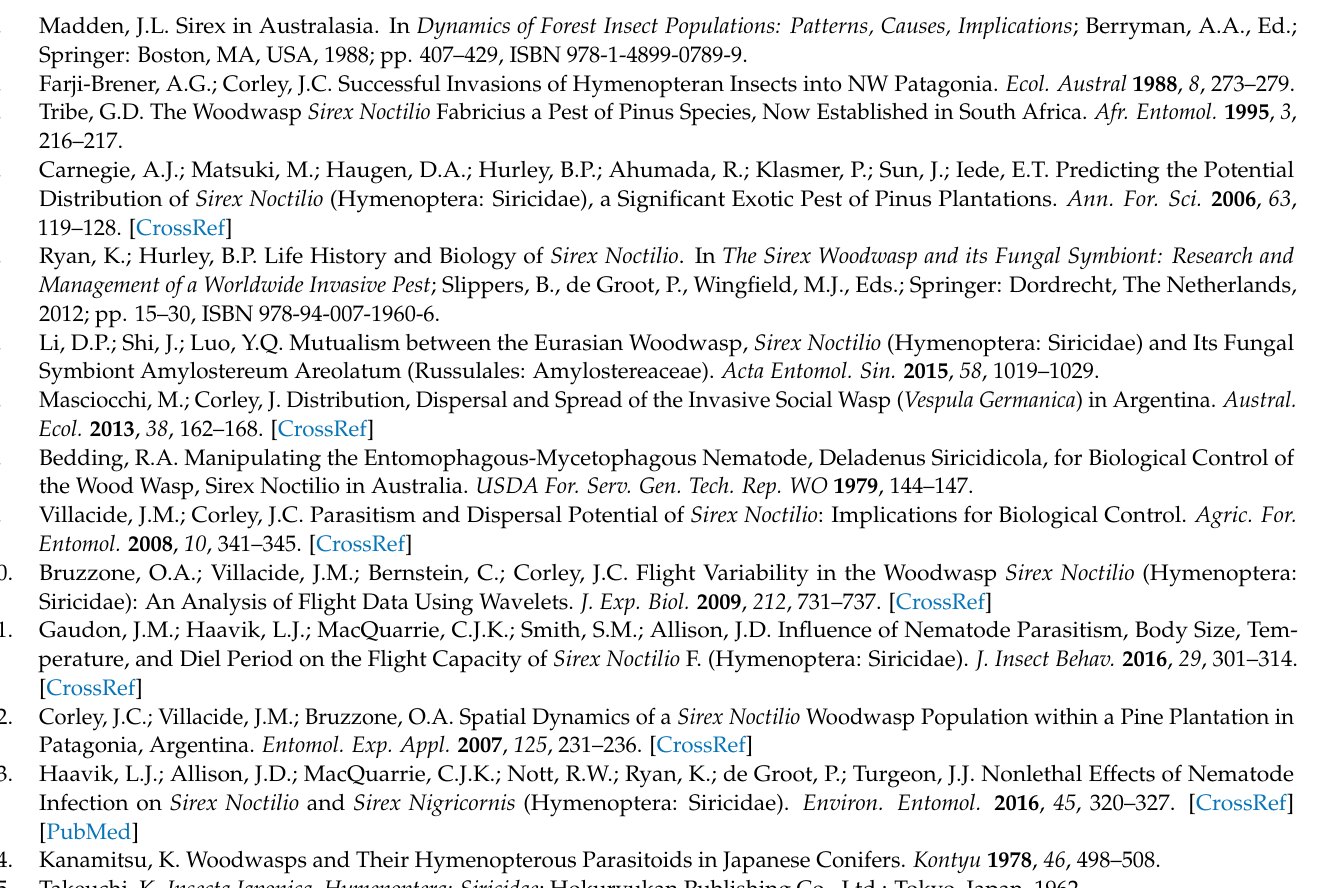
Data are presented as mean ± SE. * 0.001 ≤ p <